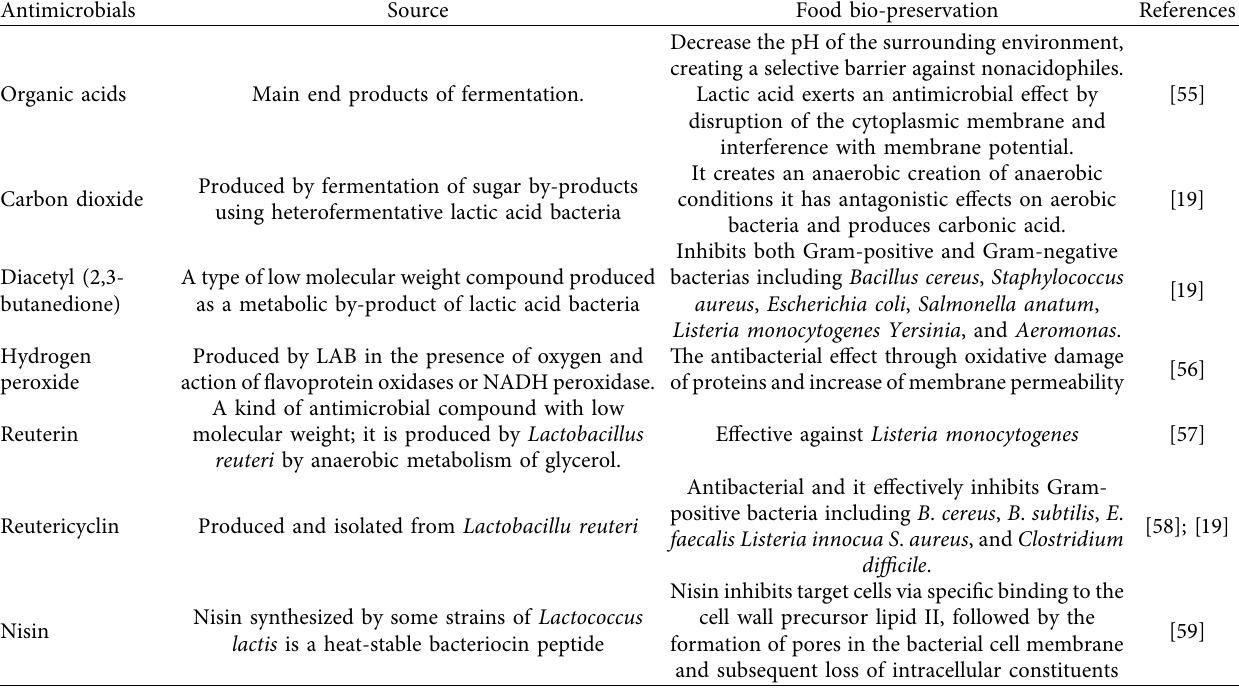
Table 3: Antimicrobial substances derived from the bacterial